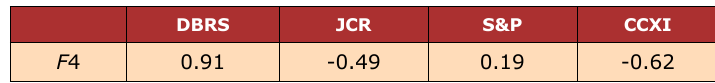
Table 11. The Assessment Value of Market Competitiveness